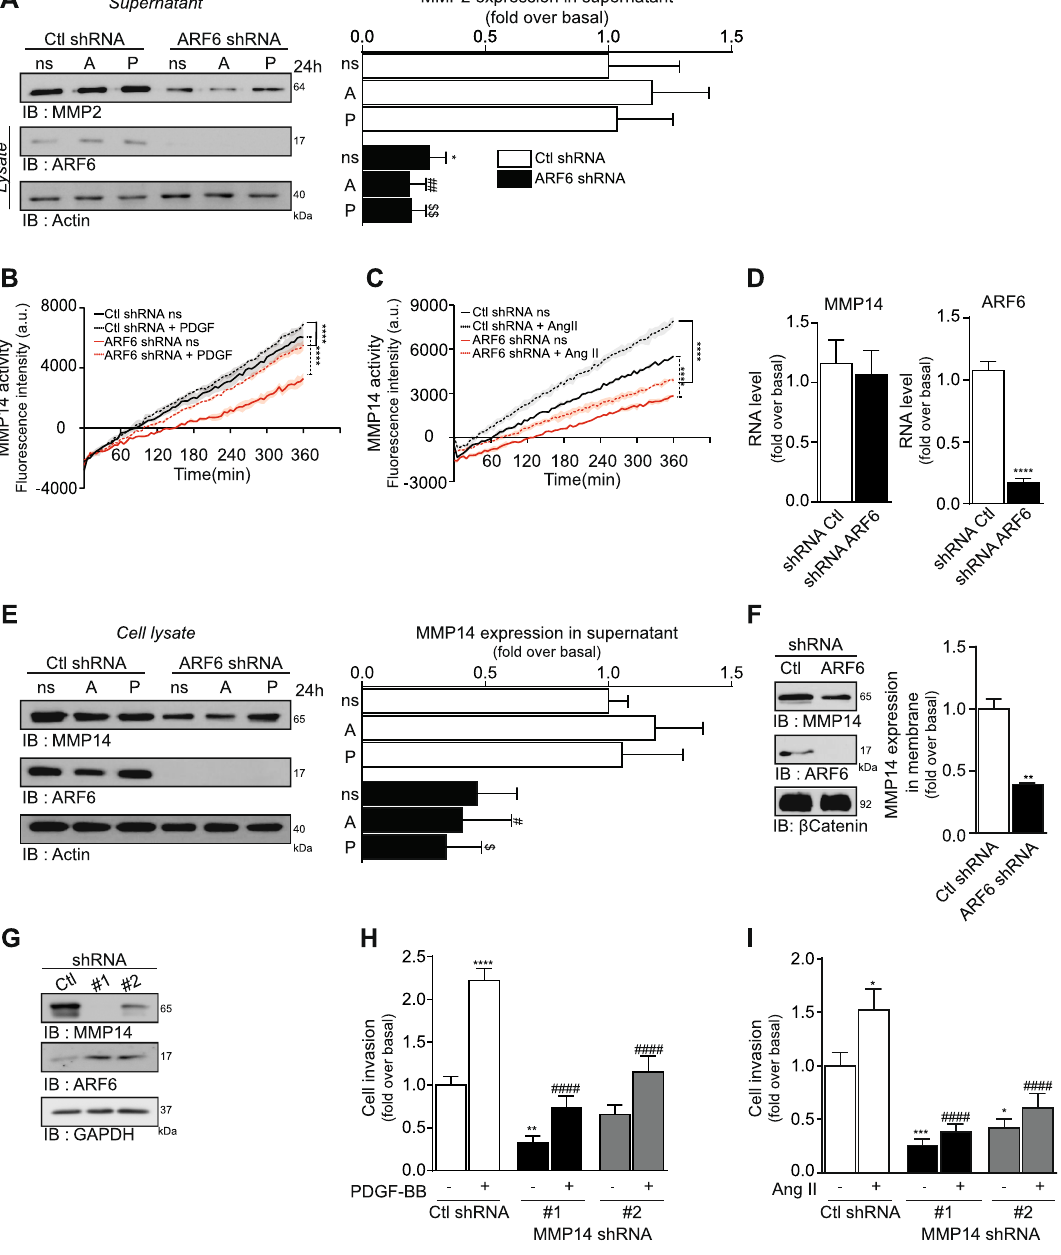
Figure 7. MMP14, essential for HASMC invasion, is regulated by ARF6. ( A ) Cells were infected with a Ctl or ARF6 shRNA, serum starved, and stimulated with Ang II (100 nM) (A) or PDGF-BB (25 ng/mL) (P) for 24 h. Supernatants were collected and concentrated. MMP2 expression was assessed by Western blotting using specific antibodies. Quantifications are the mean ± S.E.M. of six independent experiments. *P < 0.05 value compared to Ctl ns, ##P < 0.01 compared to Ctl Ang II, $$ P < 0.01 compared to Ctl PDGF-BB (Two-Way Anova). ( B , C ) Cells were infected as in ( A ). Before PDGF-BB stimulation ( B ) or Ang II ( C ) for 6 h, medium was changed for L-15 with MMP14 fluorogenic substrate (10 µM). The fluorescence intensity was measured at 328/400 nm every 5 min. Quantifications are the mean ± S.E.M. of duplicates of one experiment, representative of 3 independent experiments, ****P < 0.0001 (One-Way Anova). ( D ) Cells were infected as in ( A ) and total RNA was extracted with Qiagen RNeasy Kit according to the manufacturer’s instructions. Quantifications are the mean ± S.E.M. of three independent experiments. ****P < 0.0001 (Student’s t -test) ( E ) Cells were infected and stimulated as in ( A ). Cells were lysed and MMP14 expression was assessed by Western blotting using specific antibodies. Quantifications are the mean ± S.E.M. of three independent experiments. #P < 0.05 value compared to Ctl Ang II, $P < 0.05 compared to Ctl PDGF-BB (Two-Way Anova) ( F ) Cells were infected as in ( A ) and membrane proteins were isolated by ultracentrifugation. Quantifications are the mean ± S.E.M. of three independent experiments. **P < 0.01 (Student’s t -test). ( G ) Cells were infected with Ctl, MMP14-1 (#1) or MMP14-2 (#2) shRNA and lysed. Blots are representative of six independent experiments. ( H, I ) Cells were infected with a Ctl or two MMP14 shRNA (#1 or #2) and seeded into Matrigel-coated Boyden chambers for 1 h. Afterwards cells were left non-stimulated (ns) or stimulated with PDGF-BB ( H ) or Ang II ( I ) for 24 h. Quantifications are the mean ± SEM of six independent experiments. ( H )****P < 0.0001, **P < 0.01 comparison to the basal condition, ####P < 0.0001 compared to Ctl PDGF-BB (Two-Way Anova). ( I ) ***P < 0.001, *P < 0.05 comparison to the basal condition, ####P < 0.0001 compared to Ctl Ang II (Two-Way